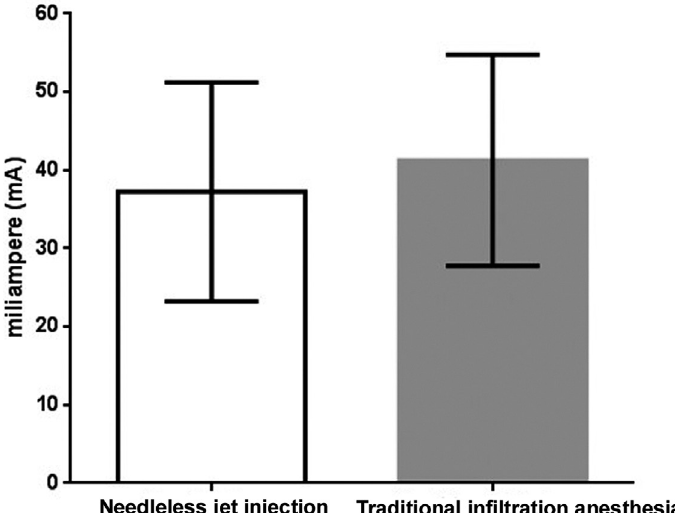
Figure 2- Basal electrical stimulation threshold (mean±standard deviation) as a function of anesthetic method. Student’s T test, p>0.05